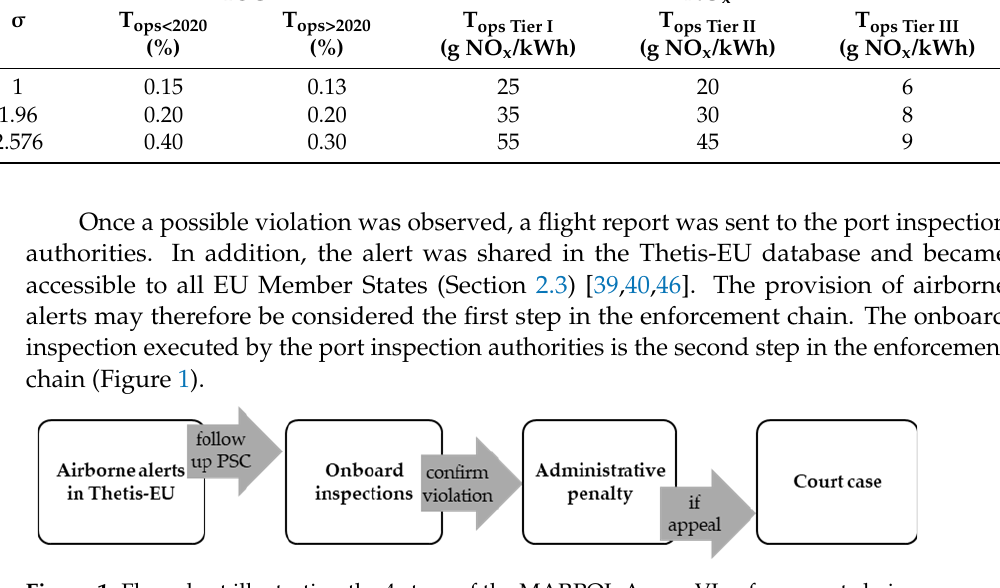
Figure 1. Flow chart illustrating the 4 steps of the MARPOL Annex VI enforcement chain.